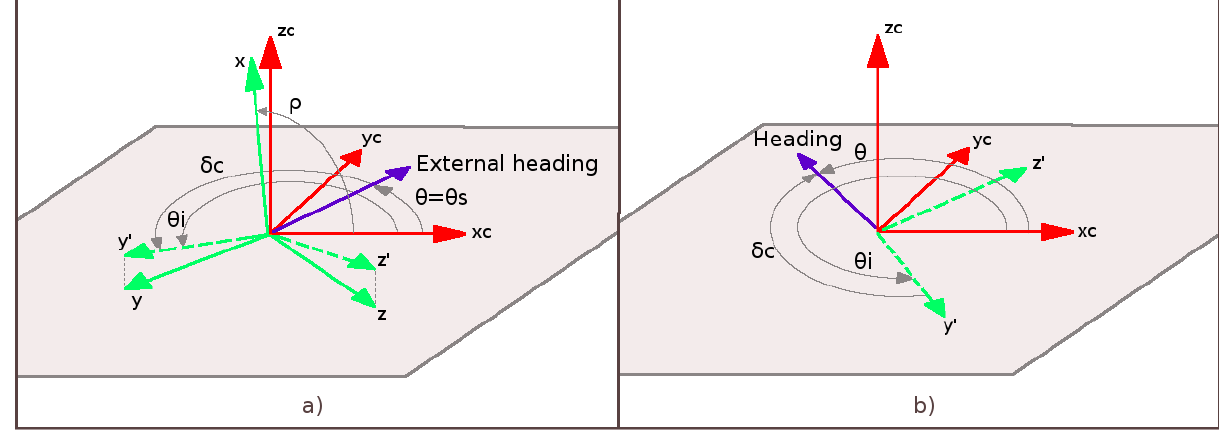
Figure 7. Coordinate frames in the process of fusion of vision and inertial information for orientation estimation. a) The moment in time when the external heading reference is available. b) Using the calculated correction angle to get person's heading at times when only the inertial